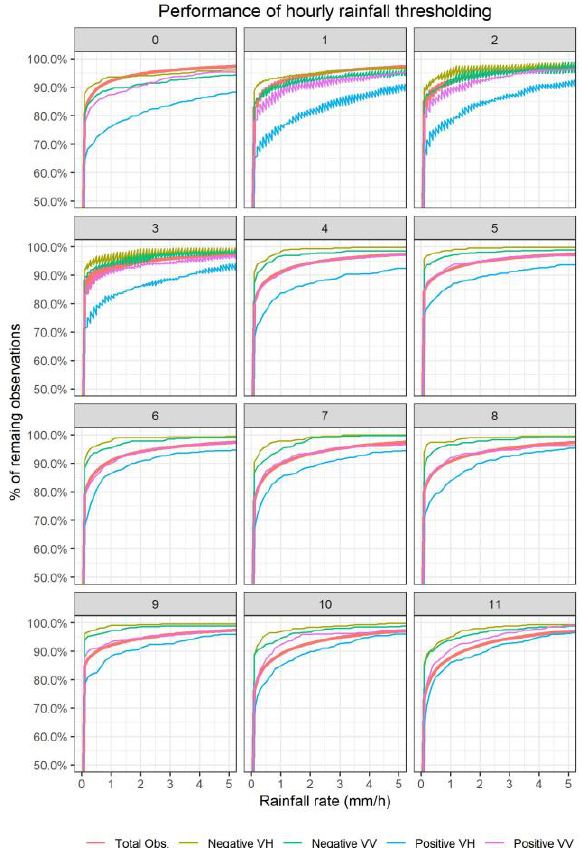
Figure 6: Results of SAR observation masking based on hourly rain rate. Every chart corresponds to the number of hours before SAR acquisition that are being considered for precipitation rate computation. Thresholds are represented in the horizontal axis, while the vertical axis represents the percentage of total and anomalous observations that were preserved after